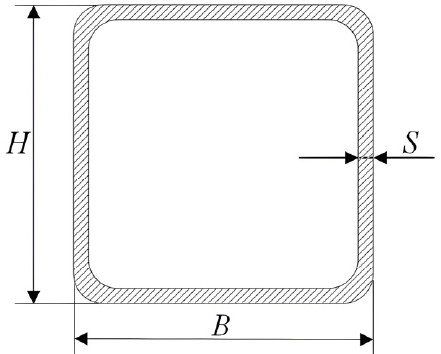
of 4.5 mm at a resistance moment of 175.7 cm 3 (Figure 7 [20,21]). One meter of the pipe weighted 24.39 kg.